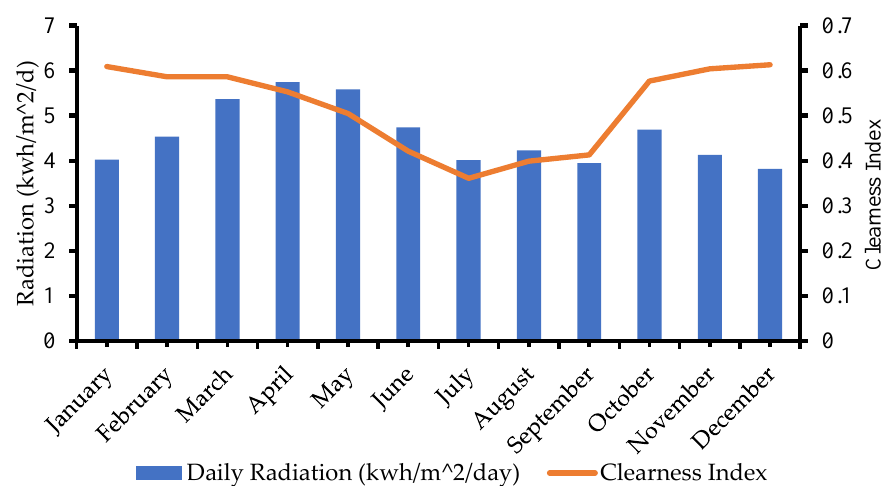
Figure 3. Monthly average solar global horizontal irradiance (GHI) data.